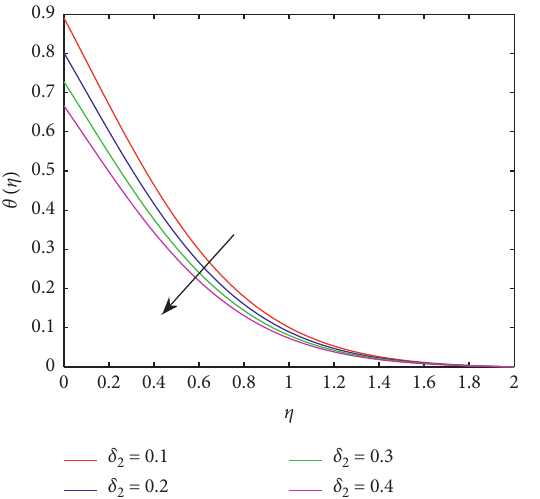
Figure 15: Variation due to S